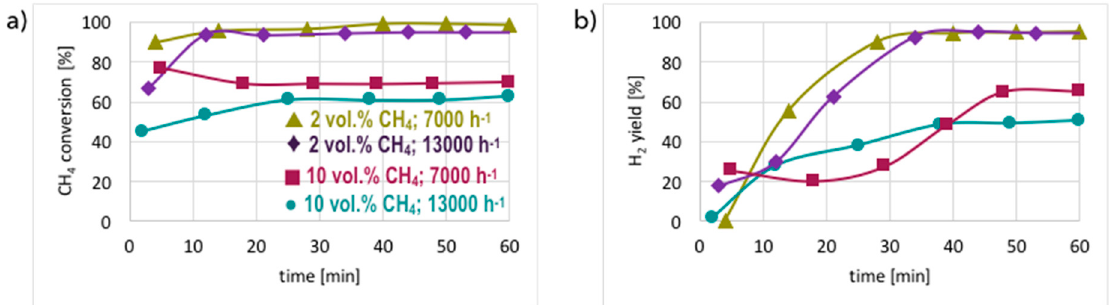
ChemEngineering 2019 , 3 , x FOR PEER REVIEW